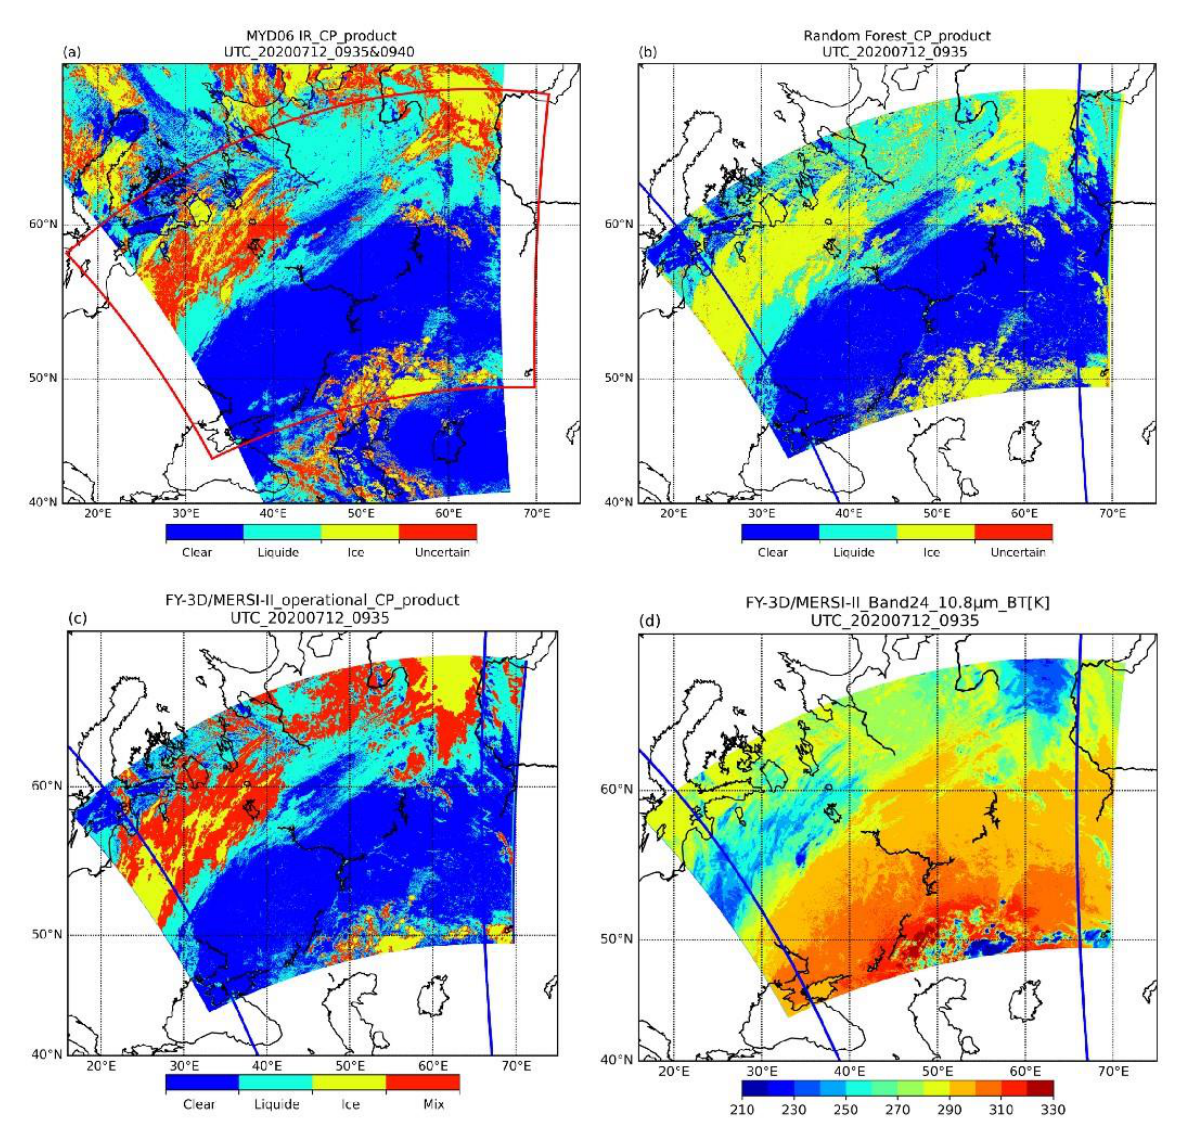
Figure 6. Comparisons of CP in mid-latitude summer, 12 July 2020, for ( a ) the MODIS CP product at 09:35 and 09:40 UTC, ( b ) the RF CP product at 09:35 UTC, ( c ) the operational FY-3D/MERSI-II CP product at 09:35 UTC, and ( d ) the FY-3D/MERSI-II band 24 BT image at 09:35 UTC. The red box is the outline of the 09:35 UTC FY-3D image, and the blue box is the contour of the 09:35 and 09:40 UTC Aqua images.